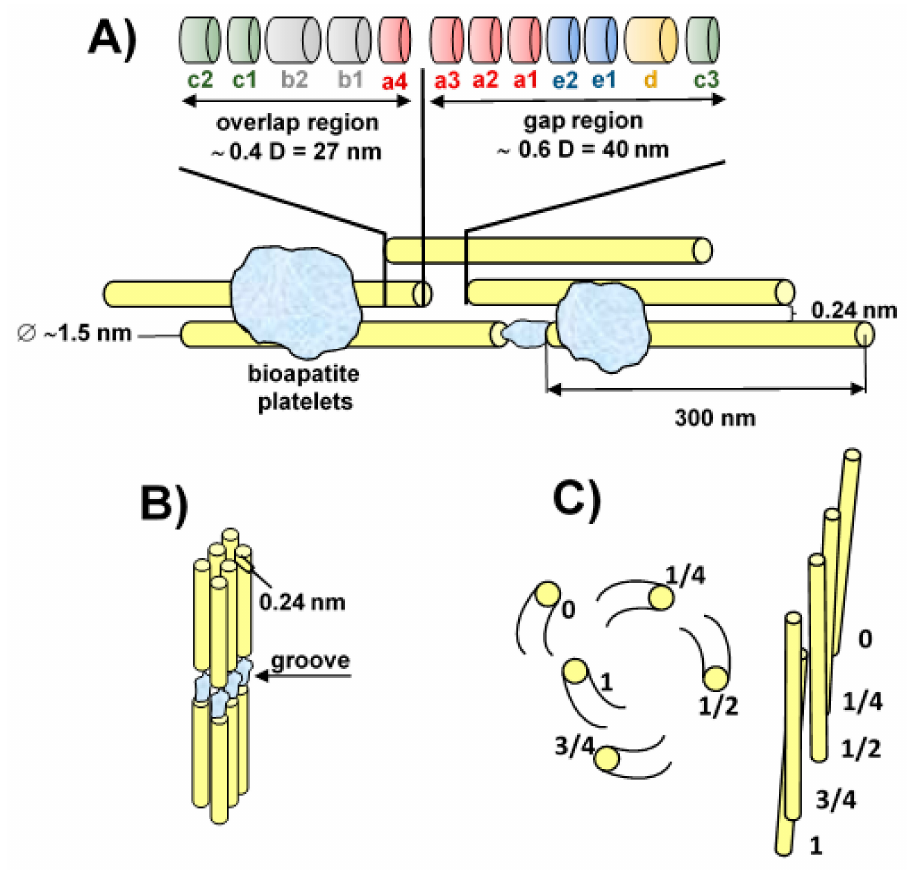
Figure 1. ( A , B ) Model for the packing of collagen molecules in bone with bioapatite platelets. Collagen molecules (straight and rod-like) are stacked end-to-end with gaps between them. ( C ) Steric model of a collagen microfibril consisting of five individual collagen molecules in a quarter-staggered arrangement labelled 0, 1 / 4, 1 / 2, 3 / 4, and 1 so as to indicate their relative height with respect to a horizontal plane. Collagen molecules are helically coiled along their